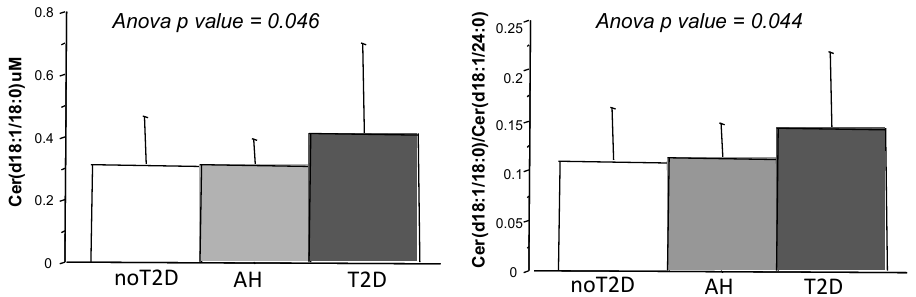
Figure 1. Levels of Cer(d18:1/18:0) and Cer(d18:1/18:0)/Cer(d18:1/24:0) in noT2D, AH, and T2D patients.